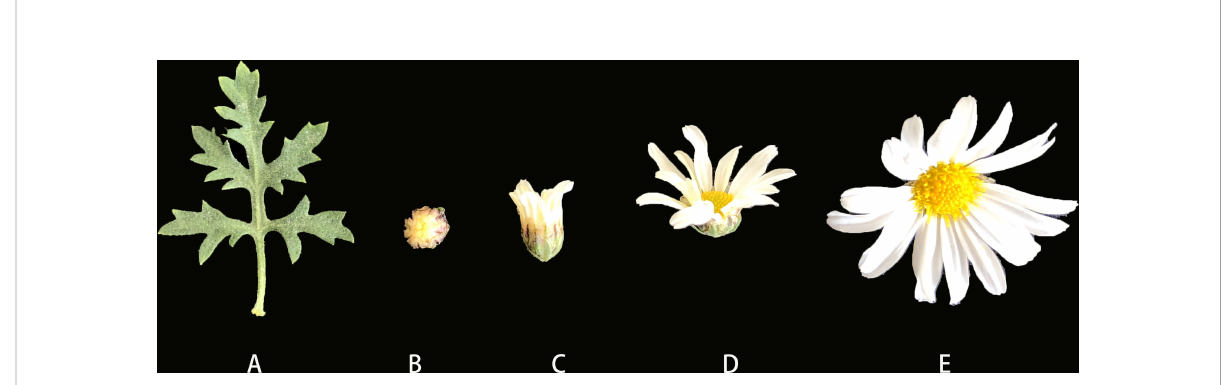
FIGURE 1 Plant material of ‘ Taihang Mingzhu ’ (A) Leaf. (B) Flower bud. (C) In fl orescence at color-development stage. (D) In fl orescence at fl owering stage. (E) In fl orescence at full-bloom